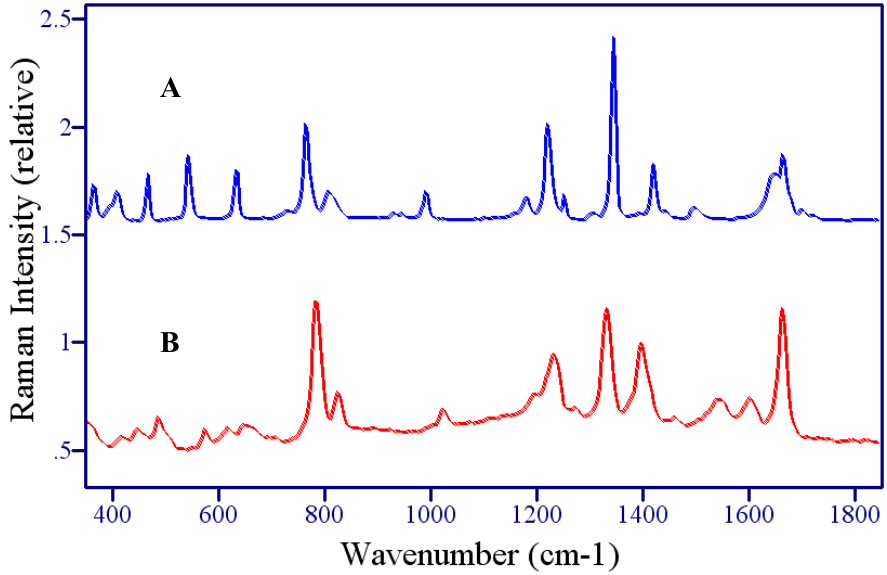
Figure 3. A) Raman and B) SER spectra of 5-fluorouracil. Conditions: A)